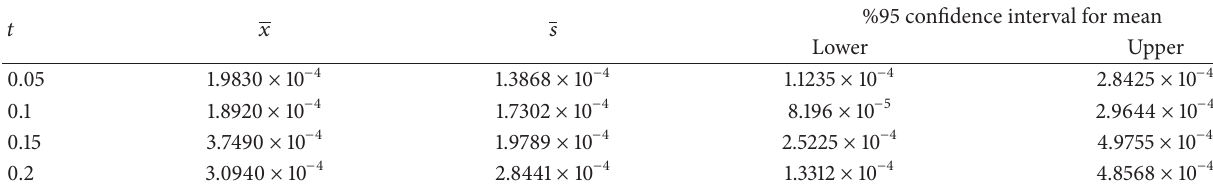
Table 2: Mean, standard deviation, and confidence interval for numerical solution mean ( 𝑇 = 0.25 , 𝐻 = 3/4